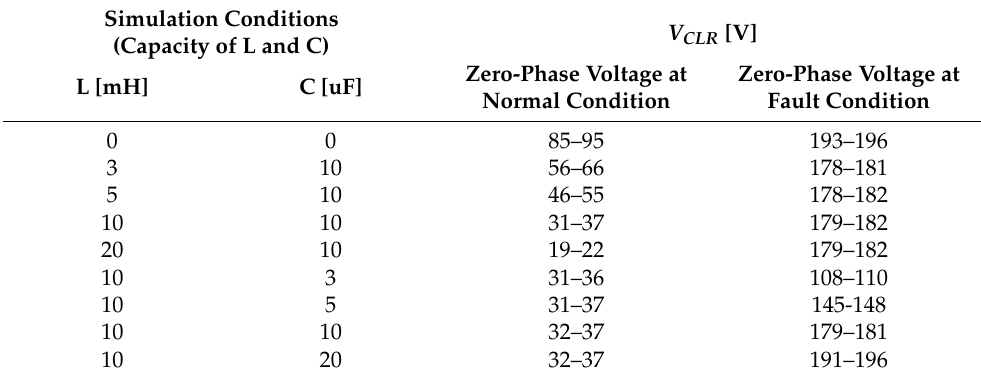
Table 3. Simulation result of GPT zero-phase voltage (according to inductor and capacitor capacity).